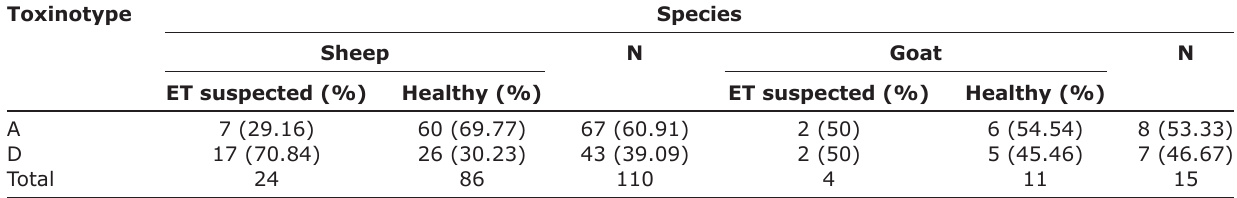
Table-2: Clostridium perfringens toxinotype distribution among healthy and enterotoxemia suspected sheep and goats. Toxinotype